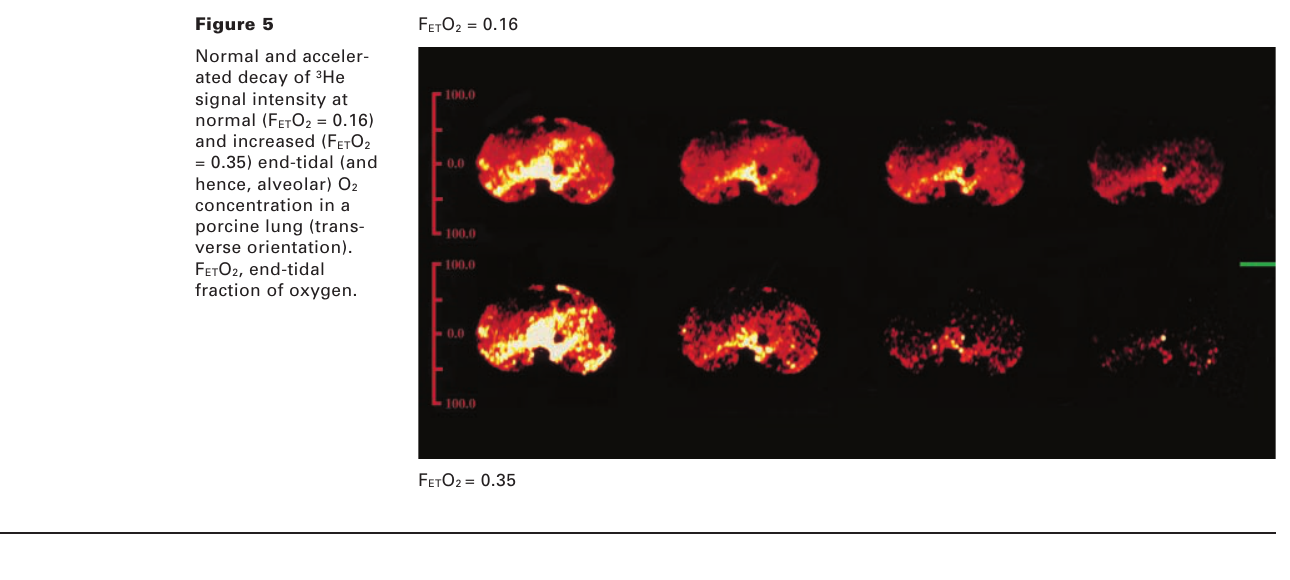
Figure 6 Left, 3 He MR projec- tion image of a healthy 25-year-old non-smoker, with regions of interest (ROIs) depicted for image-based PO 2 measurement. Right, measured regional P ROI O 2 values and their decrease during breathholding. Note homogeneity of both P ROI O 2 distribution and rate of P ROI O 2 decrease. Image- based P ROI O 2 ranged between 94 and 101 mm Hg, measured end-tidal PO 2 was 113 mm Hg.